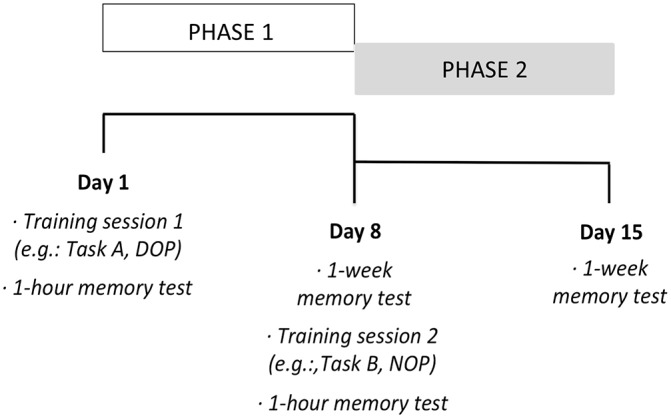
Sequential progression (from left to right) of the two phases of the study.